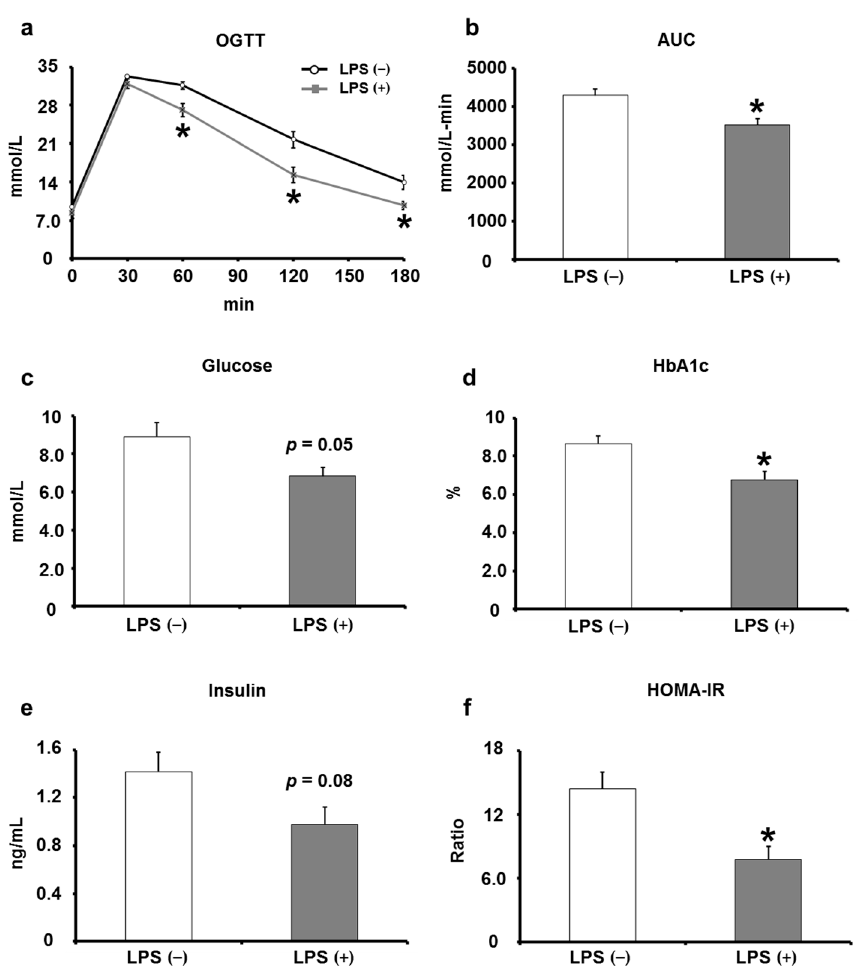
Figure 2. Effects of orally administered LPS on OGTT response, glucose, HbA1c, insulin, and HOMA-IR in KK/Ay mice. ( a ) OGTT was performed ( n = 8). ( b ) The AUC was calculated using the trapezoid rule ( n = 8). ( c ) The fasting glucose was measured using commercial kits ( n = 5–6). ( d ) The fasting HbA1c was measured by Oriental Yeast CO., Ltd. ( n = 5–6). ( e , f ) Insulin levels and HOMA-IR were measured using commercial kits ( n = 5–6). Values are presented as the mean ± SE. * p < 0.05 vs. LPS ( − ) group.